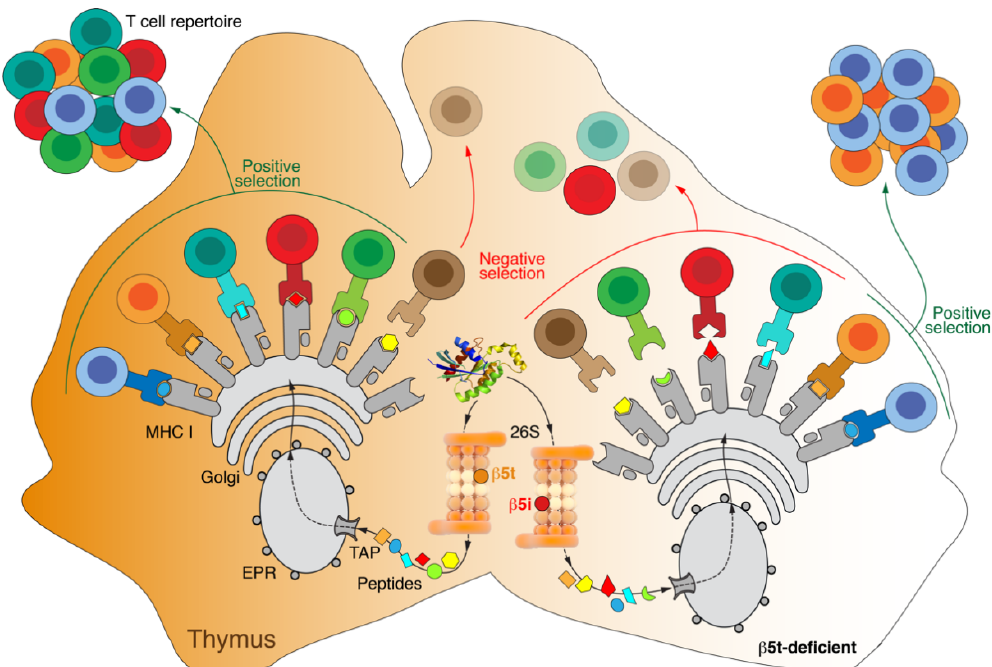
Figure A1. Thymoproteasome in the positive selection of MHC-I-specific T cells. A unique catalytic subunit, β 5t, which, together with β 1i and β 2i, is part of the 20S proteasome instead of β 5 or β 5i, forms a thymoproteasome (in orange) with reduced chymotrypsin-like activity. This type of proteasome plays an important role in the positive selection of MHC-I-specific T cells, as a result of which the final repertoire of cytotoxic lymphocytes is significantly expanded.